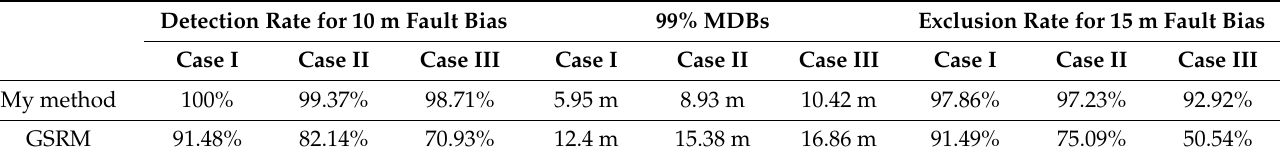
Table 2. Performance of my method and GPS stand-alone RAIM method (GSRM) on different fault bias and 99% Minimal Detectable Biases (MDBs), in different